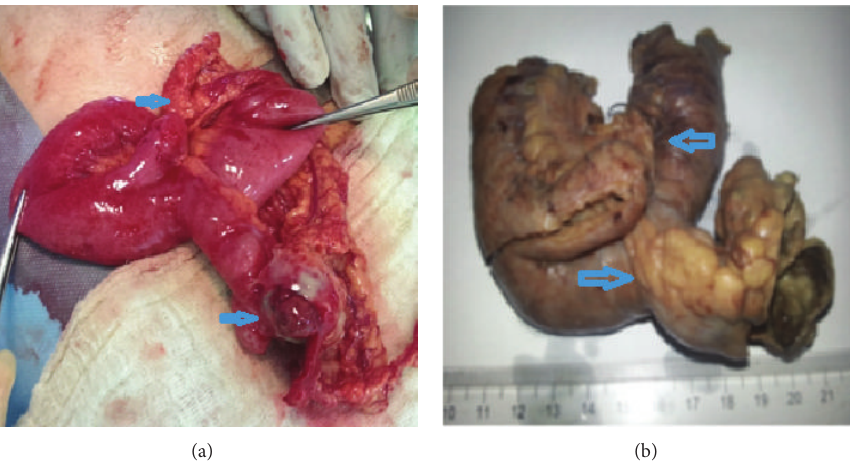
Figure 1: (a) Double Meckel’s diverticulum, one wrapped with omentum. (b) Two diverticula, located in the resected material; the right one is